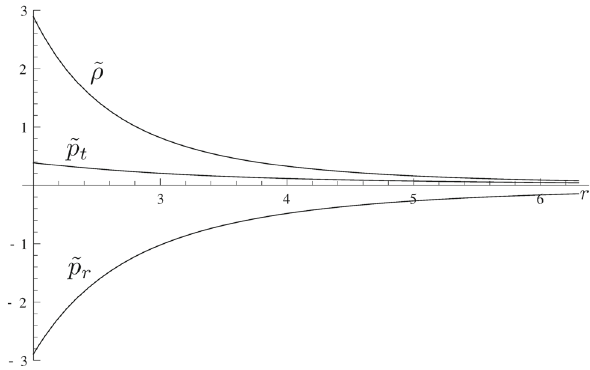
Fig. 3 Case b = 3. Effective source terms { ˜ ρ, ˜ p r , ˜ p t } × 10 3 for α = − 0 . 7 and a = 1 . 4. The horizon r = 2 M and the mass M = H